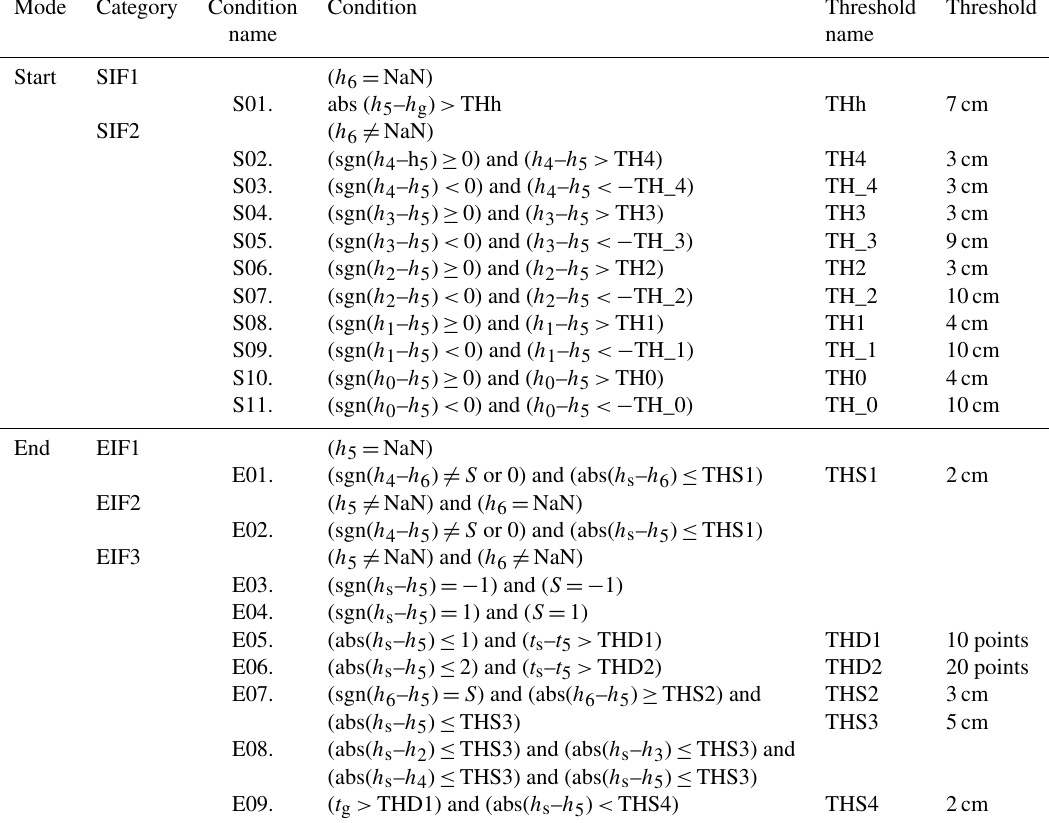
Table 1. Conditions and thresholds of an outlier removal algorithm.